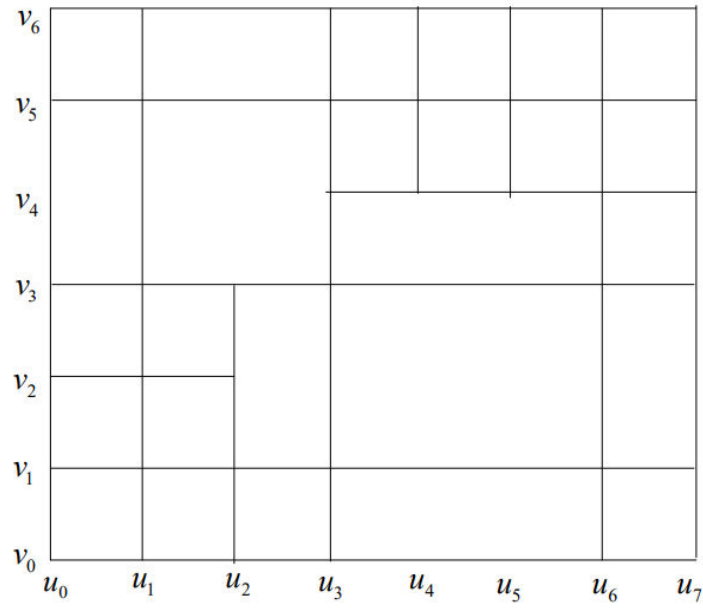
Figure 7. The second